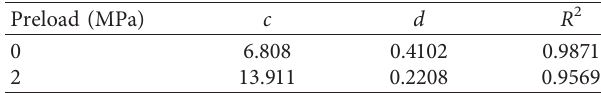
Figure 12: Relationship curve between dynamic tensile strength of the specimen and absorbed energy. Table 4: Fitting parameters of dynamic tensile strength of the limestone